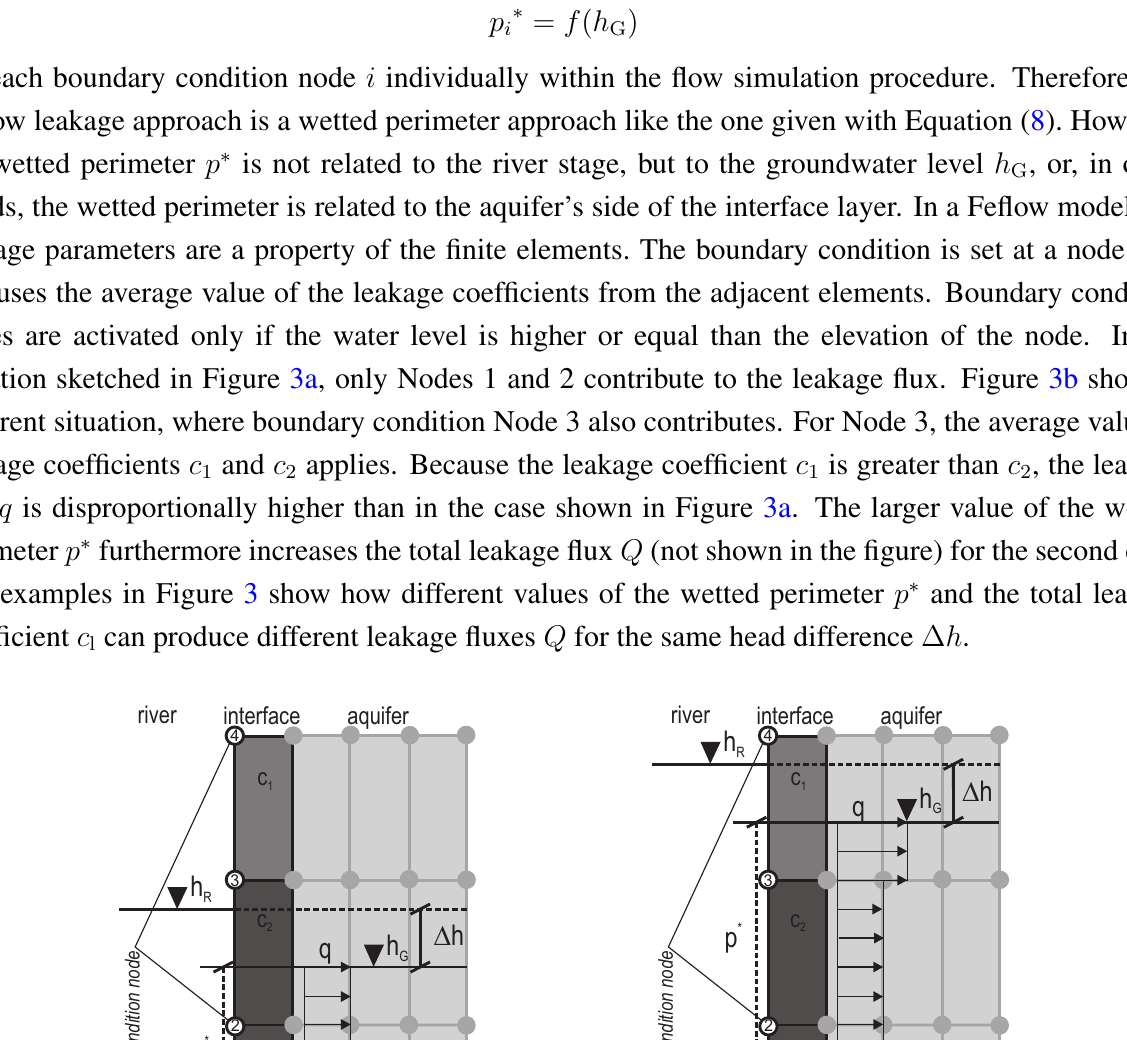
and h , but the R G